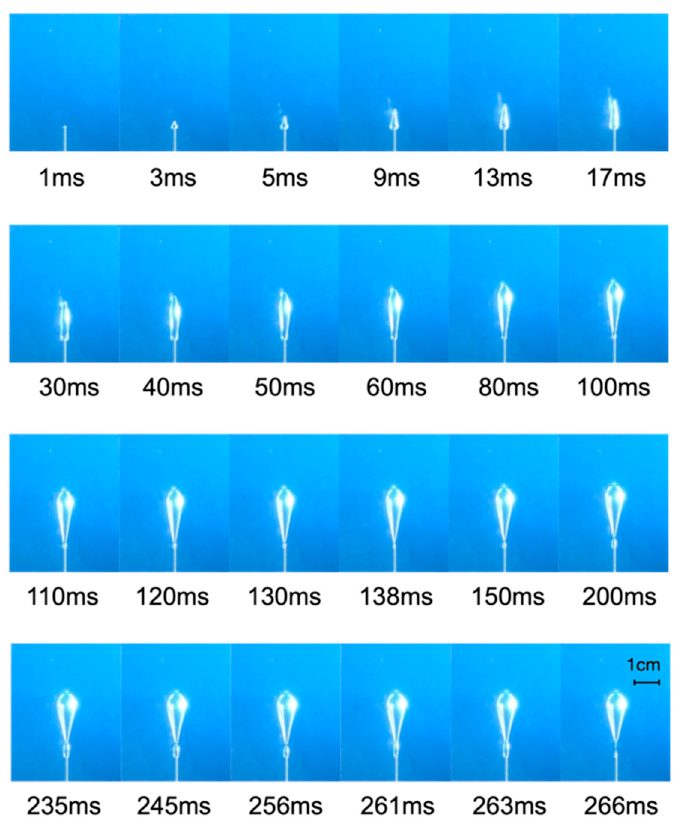
Figure 5. The major bubble growth process.